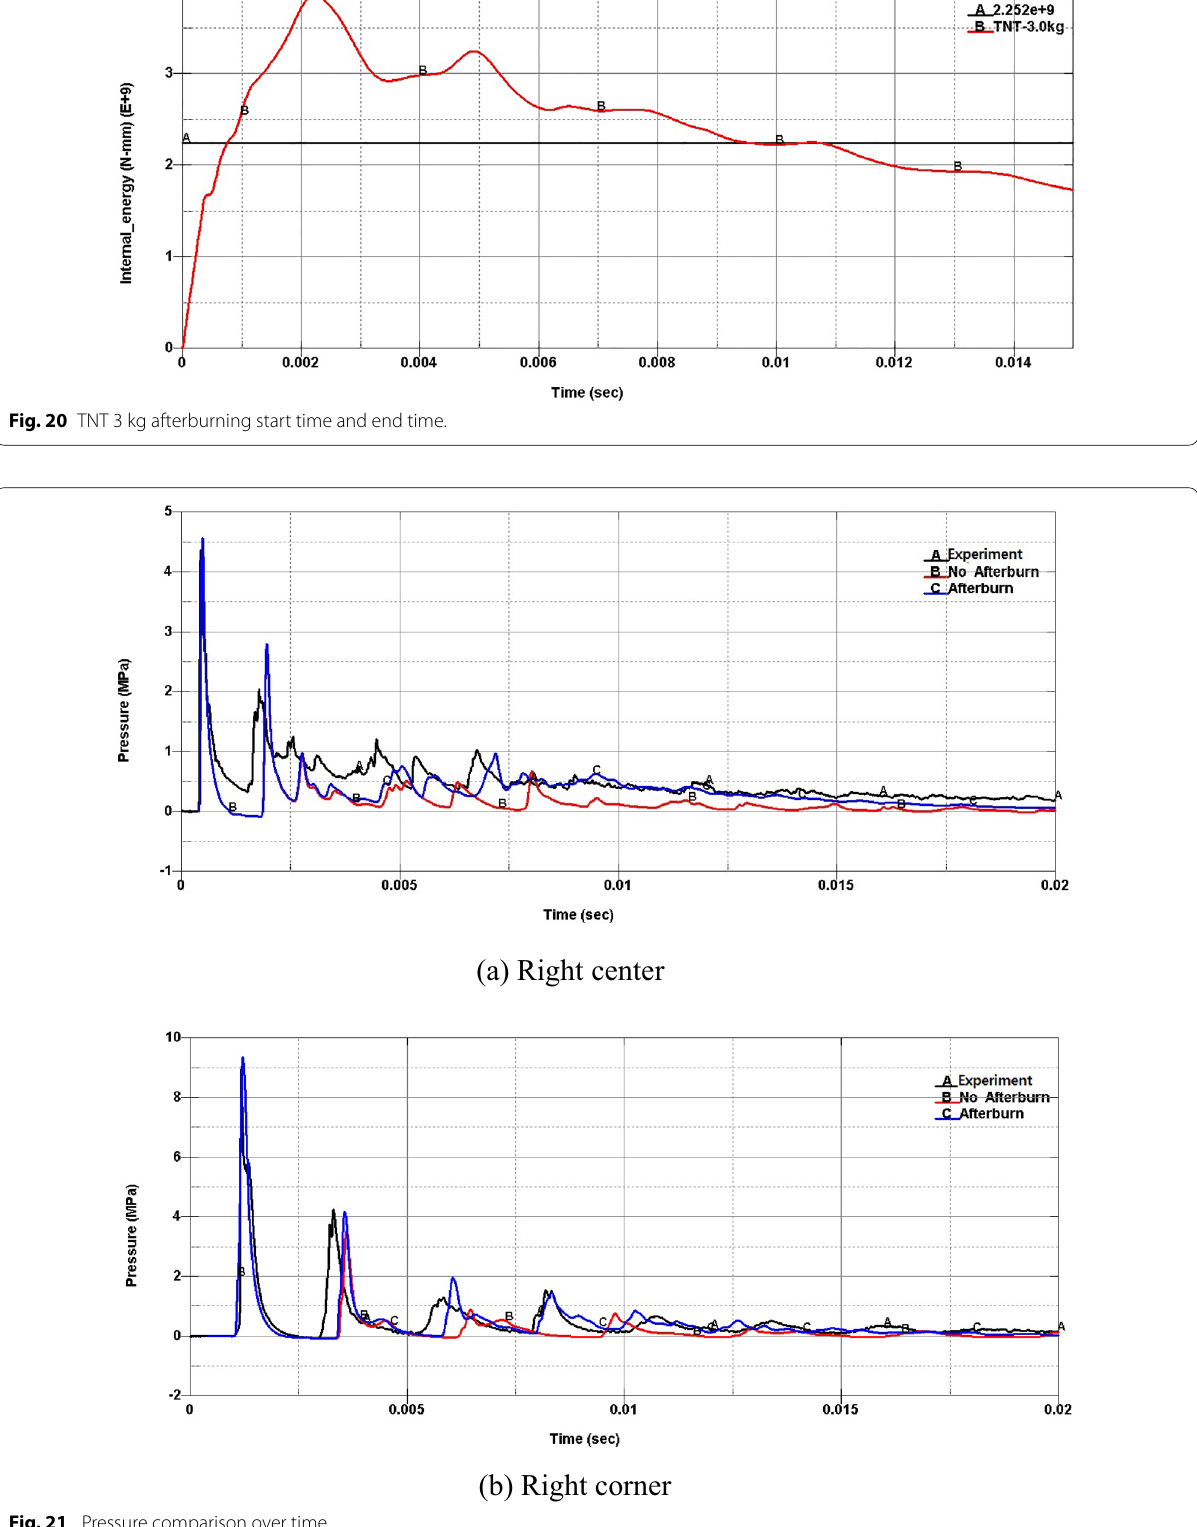
Fig. 21 Pressure comparison over